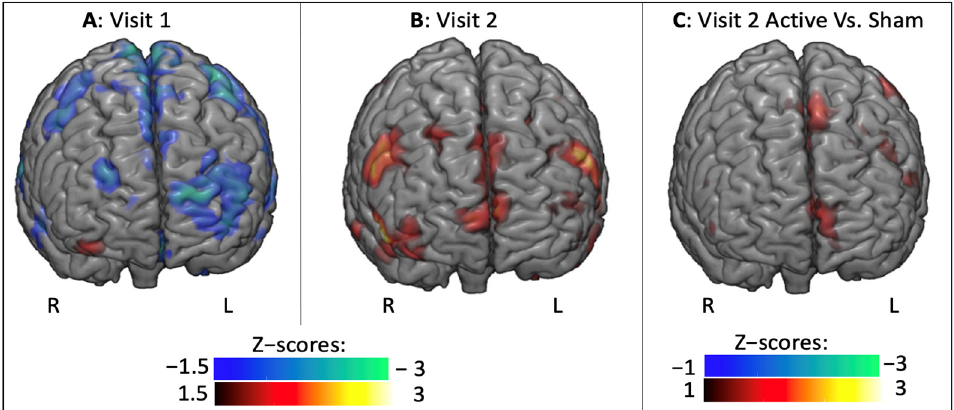
Figure 7. PPI analysis for the Fear versus Other contrast on Visit 1 ( A ), Visit 2 ( B ), and comparison of the effects of Active versus Sham rTMS on the second visit ( C ). Blue colors indicate decreased connectivity; and red colors indicate increased in functional connectivity.